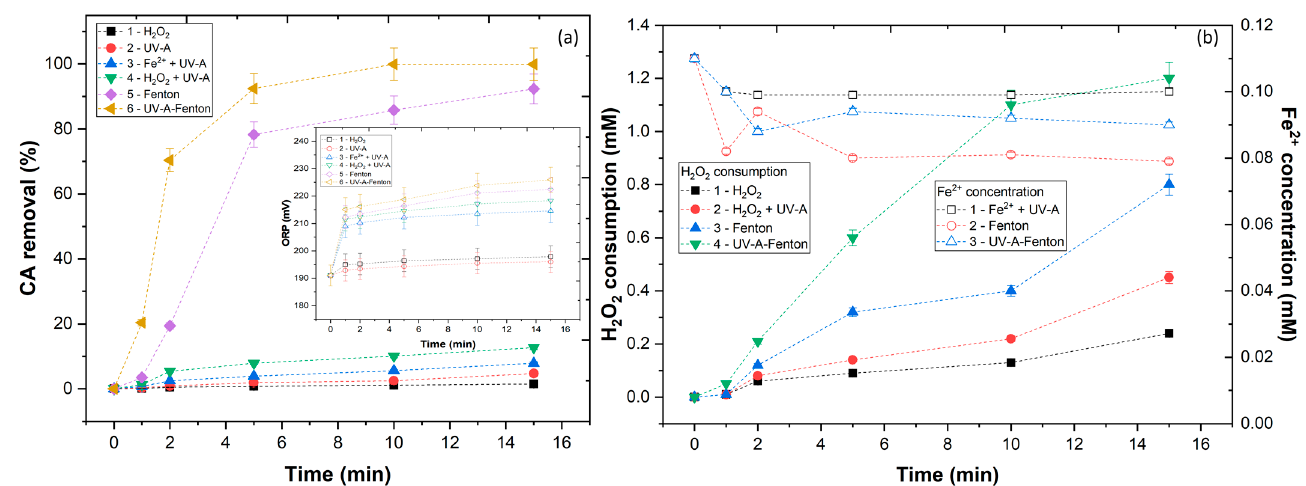
Figure 2. Assessment of different AOPs in ( a ) CA removal and ORP variation and ( b ) H 2 O 2 consumption and Fe 2+ concentration. Operational conditions: [CA] = 5.5 × 10 − 4 mol L − 1 , [H 2 O 2 ] = 22 × 10 − 4 mol L − 1 , [Fe 2+ ] = 1.1 × 10 − 4 mol L − 1 , pH = 3.0, agitation 150 rpm, temperature = 298 K, radiation UV-A, I UV = 32.7 W m − 2 , t = 15 min.